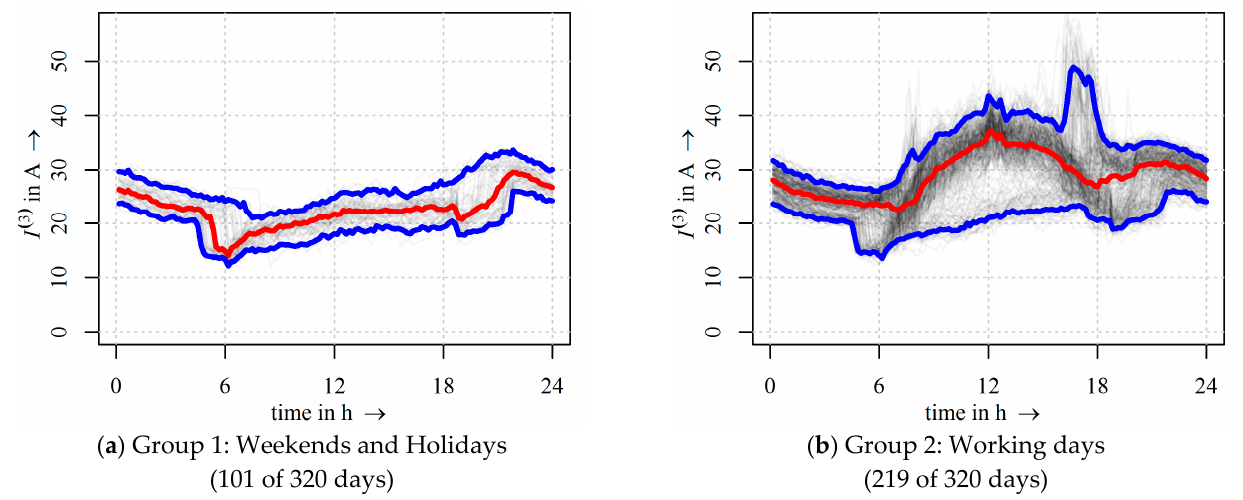
Figure 2. Profile of the 3rd harmonic current for an office building; median (red), 5th and 95th percentile (blue), daily time series (grey); aggregation interval: 10 min; measurement duration: 320 days from January to December 2012.